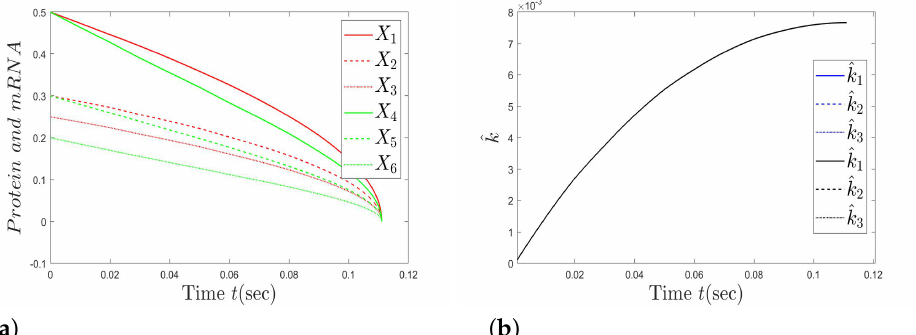
Figure 2. The adaptive design of switched SGRNs with time-varying delay, where the controller is (19), and the adaptive law is (20). ( a ) Evolution of mRNA X 1 , X 2 , X 3 and protein molecules X X X 5 , 6 , ( b ) evolution of the controller gain of mRNA k 1 , k 2 , k 3 and protein molecules k 4 , k 5 , k 6 4 ,